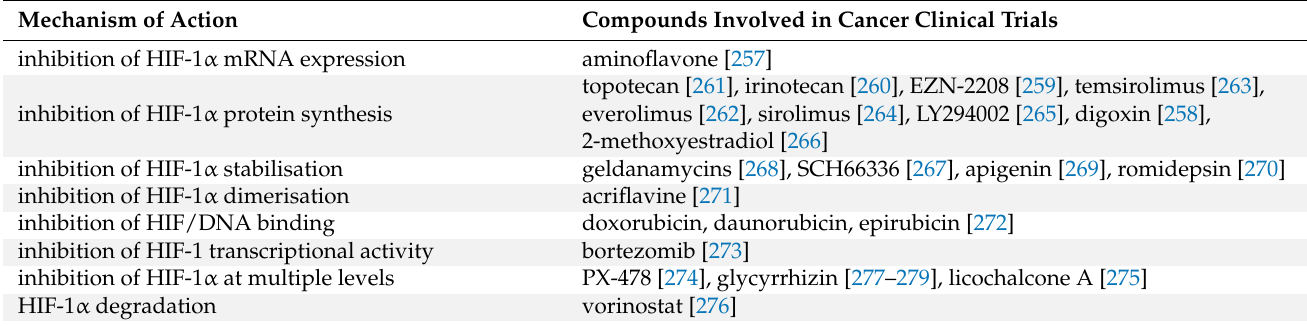
Table 2. An example of agents targeting the HIF-1 α pathway that have been tested in clinical trials. Mechanism of